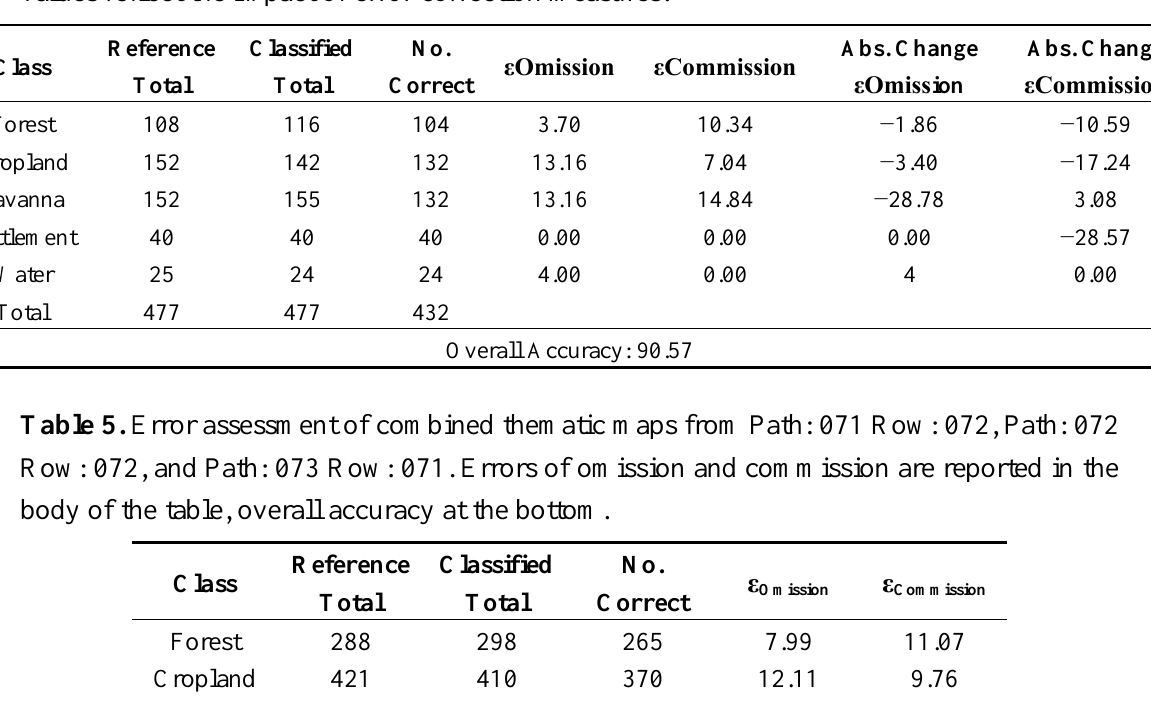
Table 4. Error assessment of thematic land cover map at Path: 172 and Row: 071. Absolute changes in errors of omission and commission are reported in the last two columns. These values reflect the impact of error correction measures.